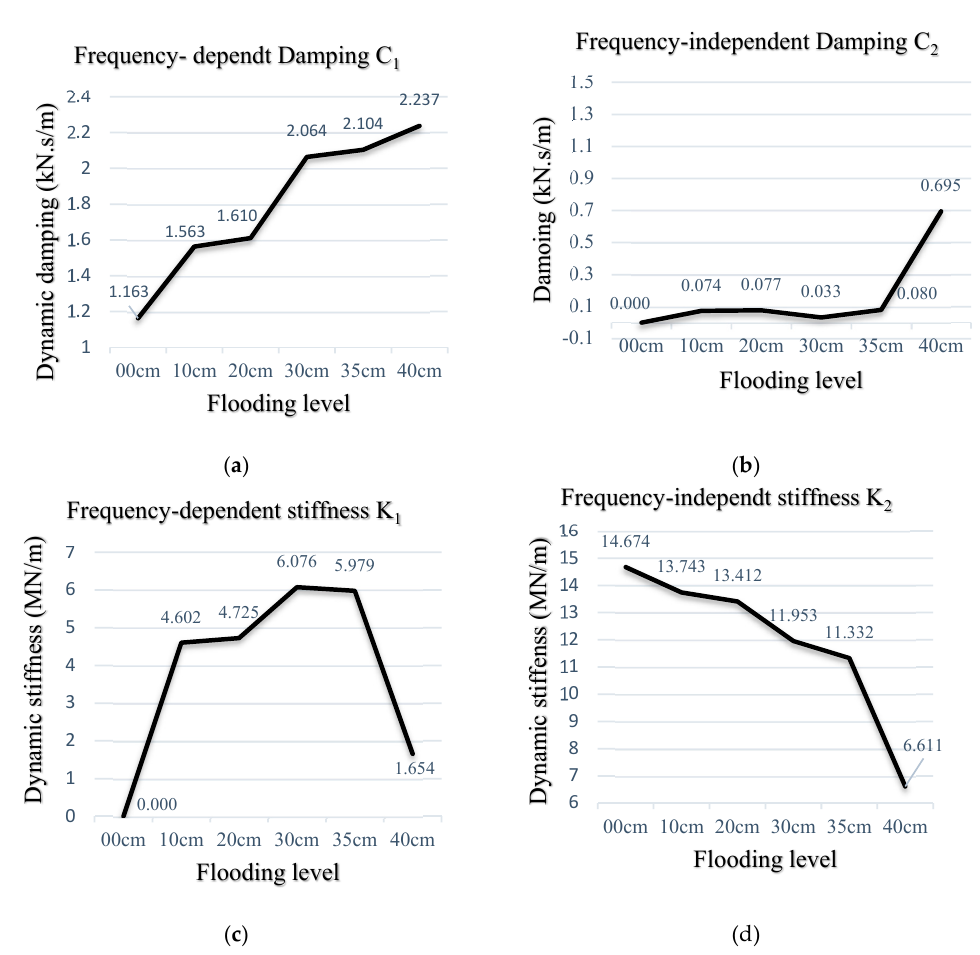
Figure 23. ( a ) Frequency-dependent dynamic in Model-4. ( b ) Frequency-independent dynamic in Model-4. ( c ) Frequency-dependent sti ff ness in Model-4. ( d ) Frequency-independent sti ff ness in